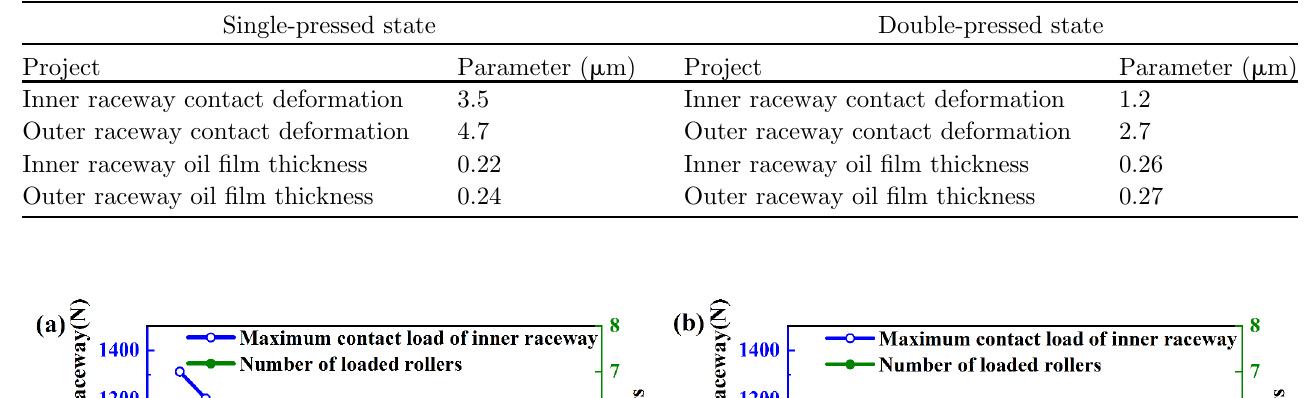
Table 3. The results of contact deformation and oil fi lm thickness.